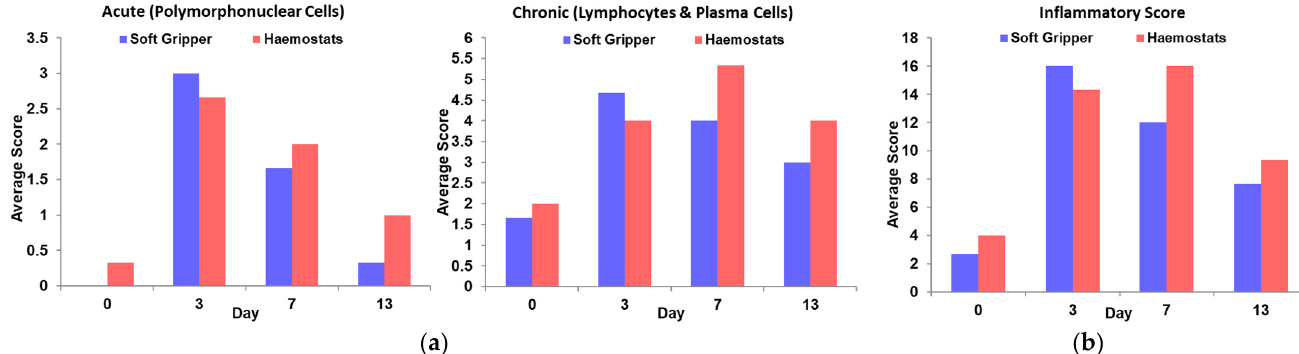
Figure 6. The average score of ( a ) acute, chronic and ( b ) overall inflammation from the histological analysis.